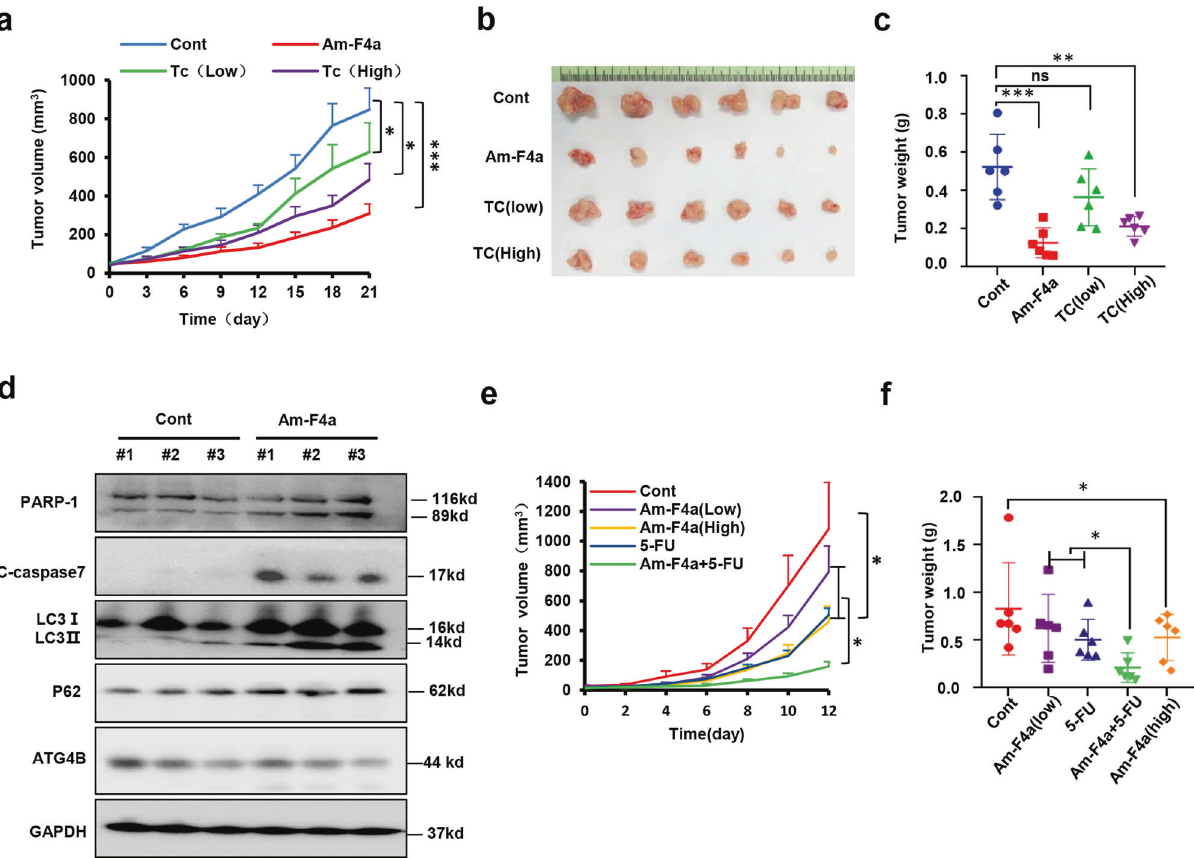
Fig. 5 Am-F4a inhibits GCa tumor growth and sensitizes 5-FU treatment. a – c Effects of the indicated treatments (Am-F4a 5 mg/kg, TC low 50 mg/kg, TC high 100 mg/kg, or vehicle, i.p., 5 times per week) on the growth of MGC803 cell-based xenografts. Representative tumor image and tumor weight at the end time point were captured. Mean tumor volume ± S.E.M ( a ) and mean tumor weight ± S.E.M ( c ) were shown. d Immunoblotting analysis of indicated proteins in MGC803 xenograft tumors after 21 days of treatment with vehicle or Am-F4a, as in ( a ), representative images were shown. e , f Effects of the indicated treatments (Am-F4a low 2.5 mg/kg, Am-F4a high 5 mg/kg, 5-FU 20 mg/kg, Am- F4a low 2.5 mg/kg and 5-FU 20 mg/kg, or vehicle, i.p., 5 times per week) on the growth of PDX xenografts. Mean tumor volume ± S.E.M ( e ) and mean tumor weight ± S.E.M ( f ) were shown. All Data shown above was calculated using two-tailed Student ’ s t test, n = 6 mice per group, * p < 0.05, ** p < 0.01, *** p <